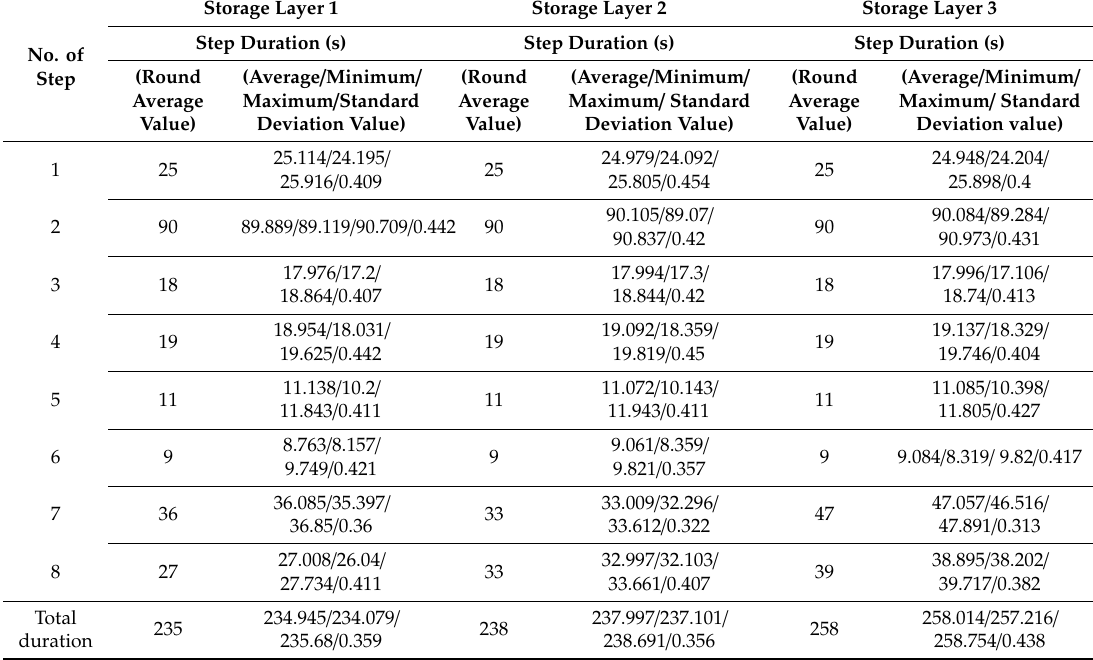
Table 3. The combinations of operations pairs: Operation No. 1 and No. 2, No. 1 and No. 3, and No. 1 and No. 4. Source: own